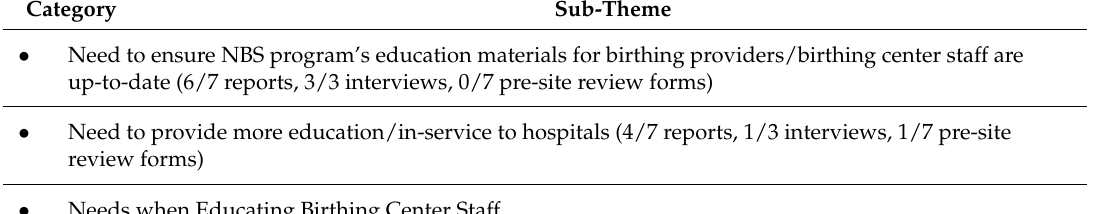
Table 3. Needs identified in State Newborn Screening Program Site Reviews: Birth Provider and Facility Education themes identified (Number of times reported in site review report, individual interview, and pre-site review